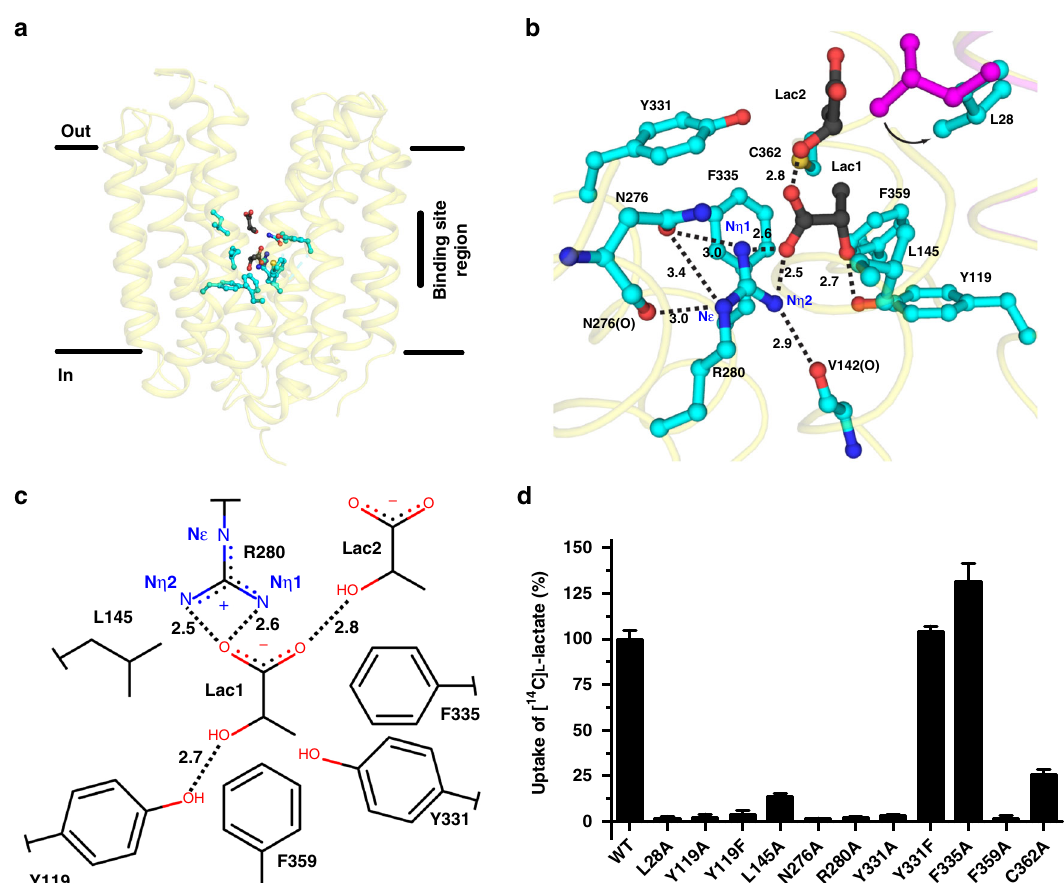
Fig. 5 Binding pocket of SfMCT with bound L -lactate. a Overall structure of SfMCT in the outward-open conformation viewed in the plane of the membrane with indicated L -lactate (black) and binding site residues (cyan). b Binding mechanism of L -lactate to SfMCT. Residues within a distance of 4 Å from the two L -lactate molecules, N276, C362 and the peptide backbone of V142 are highlighted in cyan. L28 and the peptide backbone of TM1 from the SfMCT structure with bound TSA are shown in magenta. The conformational change of L28 occurring upon L -lactate binding is indicated by an arrow. c Two- dimensional schematic representation of residues that are involved in L -lactate-binding. Distances in ( b , c ) are given in Ångström (Å). d Determination of the role of TSA- and L -lactate binding residues on [ 14 C] L -lactate transport using an in vivo uptake assay. Transport activities of SfMCT mutants were normalized with respect to wild-type protein (WT). Data are represented as mean ± SEM from at least three independent experiments, each in triplicate. Source data are provided as a Source Data fi